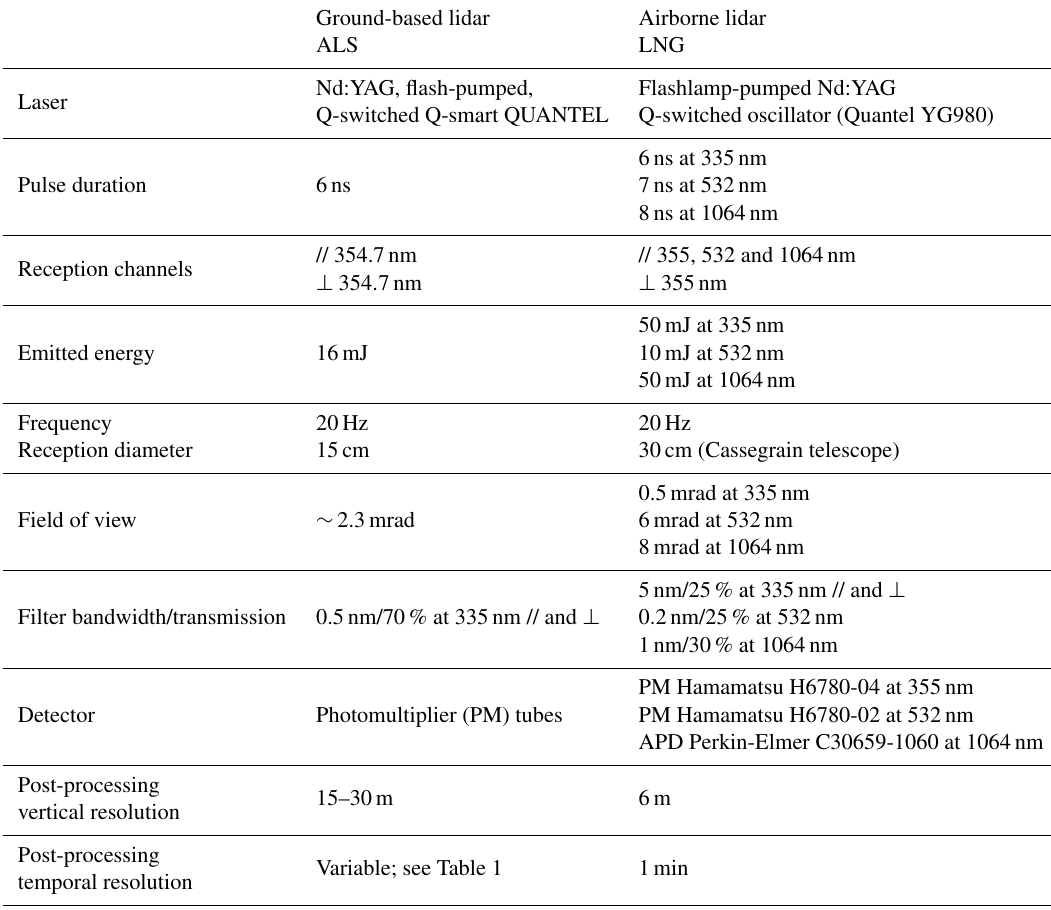
Table A1. Main characteristics of both the ALS and LNG lidars. Ground-based lidar Airborne